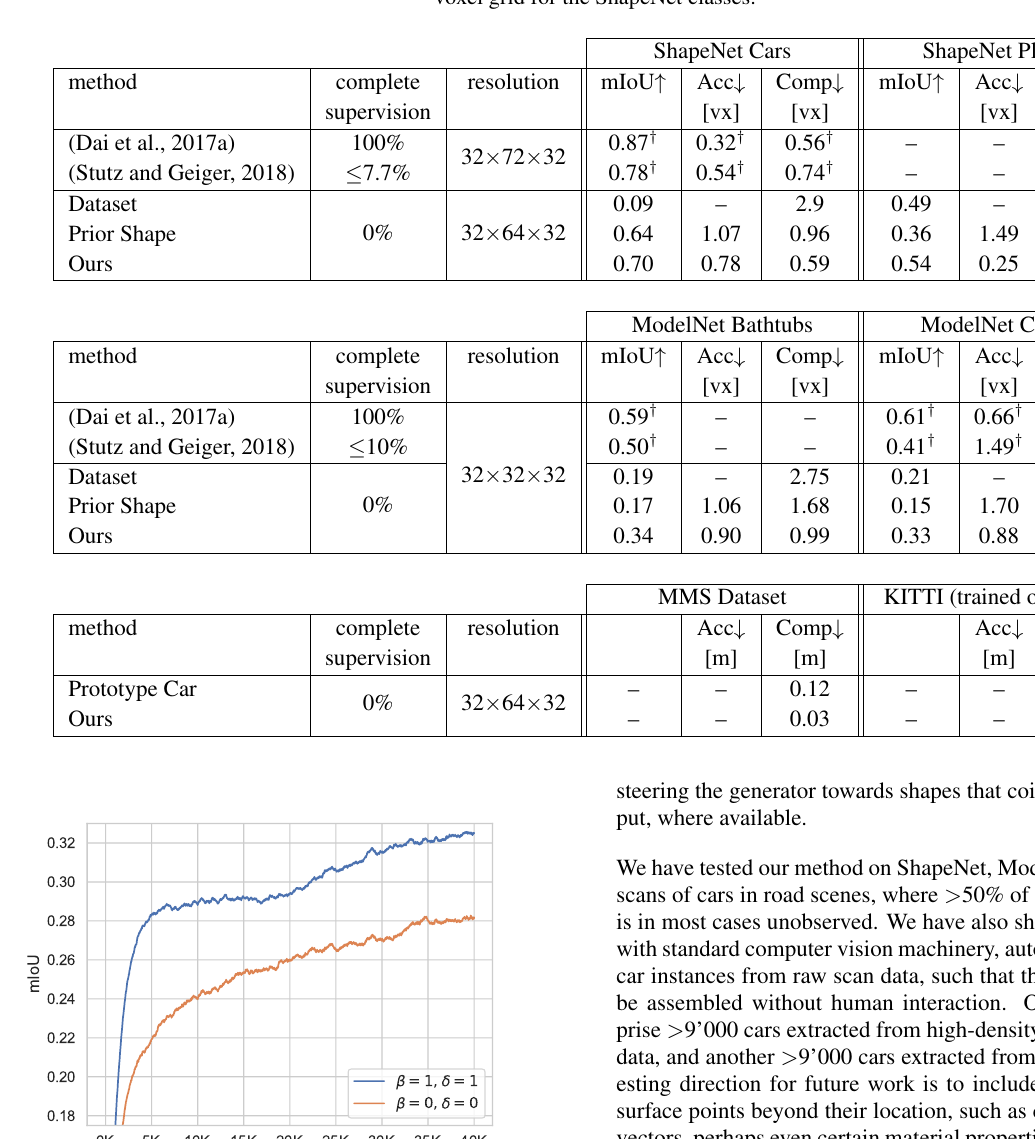
Table 1. Quantitative Results. Numbers marked with † are taken from (Stutz and Geiger, 2018). Note that they use a slightly different voxel grid for the ShapeNet classes.